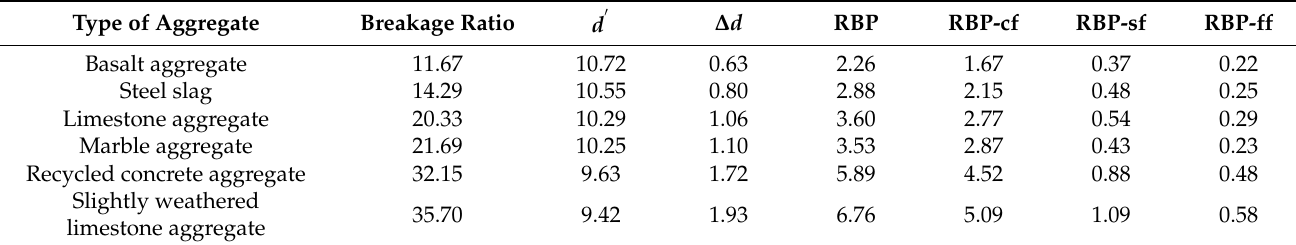
Table 12. Results of aggregate crushing characteristics after roller